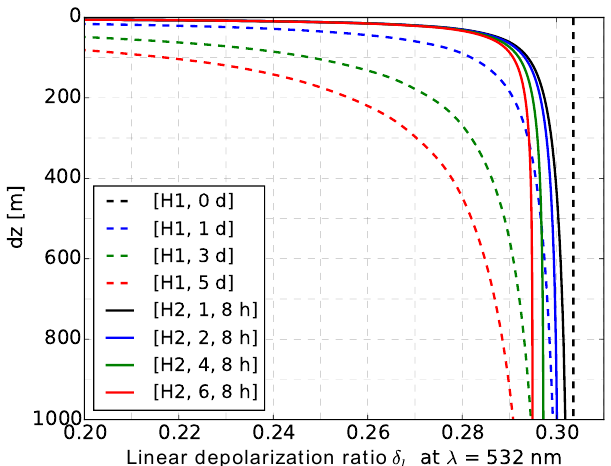
Figure 6. Analogous to Fig. 5, but assuming mixtures of different shapes of mineral dust particles as indicated in the legend (shapes BCDF = reference ensemble). The solid lines show profiles for [H1, 5d]. The dashed lines show the same profiles when no shape depen- dence of the settling velocity is assumed ( ξ vc of all shapes is set to the average value, which is given in the legend). The dotted lines show the modeled profile at the beginning of the settling.